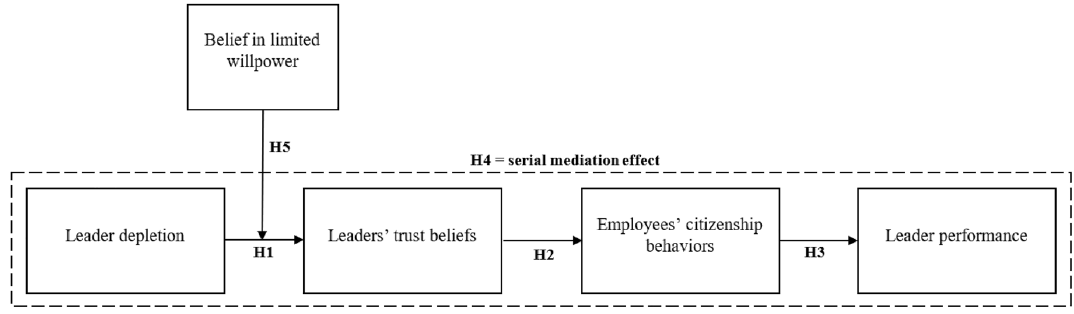
Figure 1. Conceptual model of the effects of leader depletion on leader